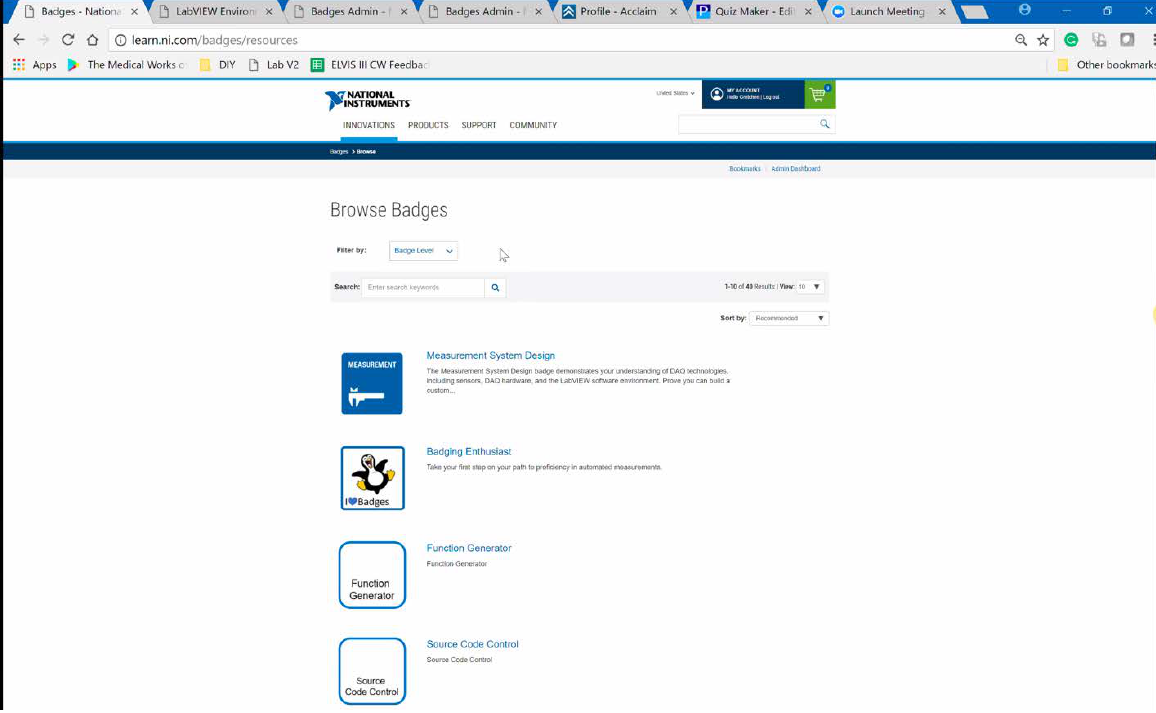
Figure 3 . Browse feature for National Instruments badges. From “Browse Badges,” by National Instruments, 2019 (https://learn.ni.com/badges/resources). In the public